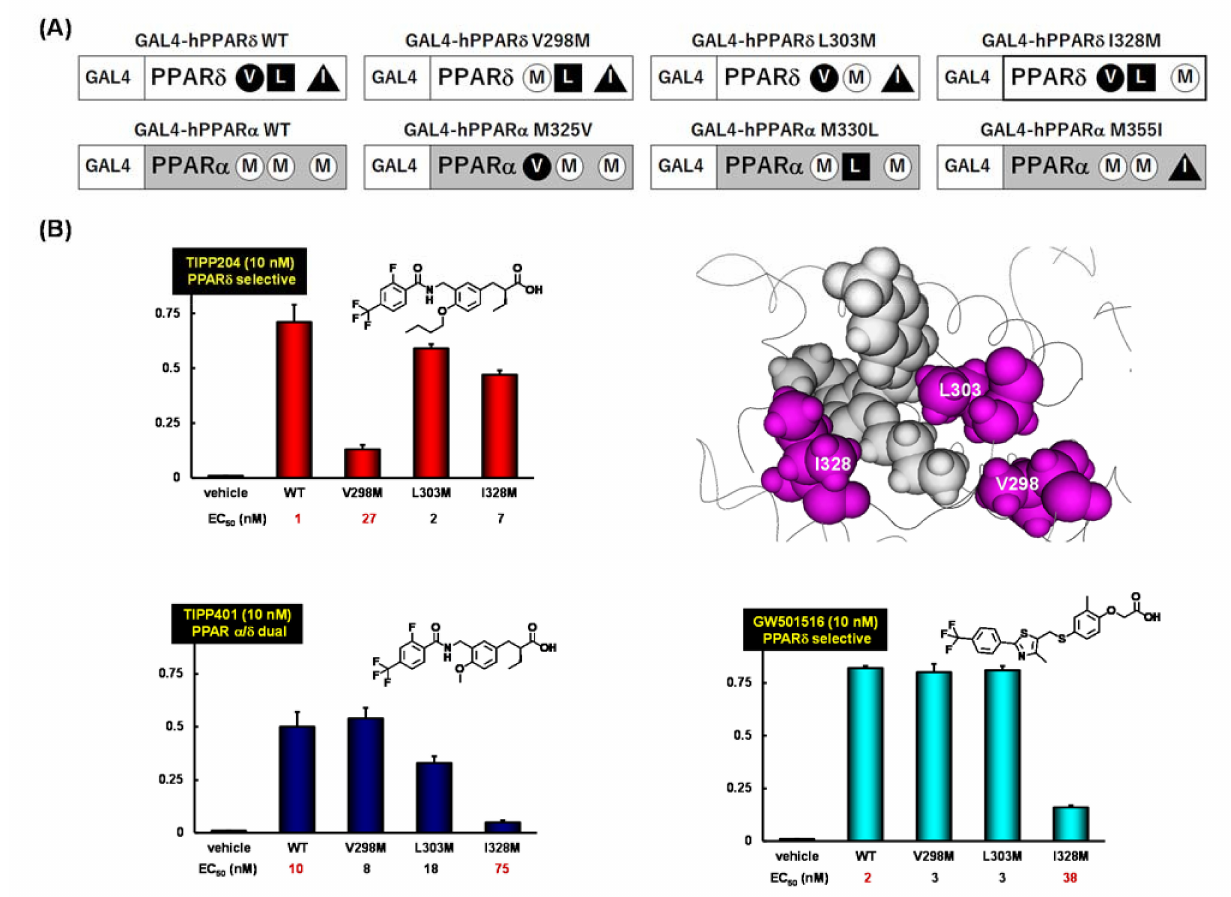
Figure 10. ( A ) A schematic representation of GAL4-fusion point mutants; ( B ) Dose responses for transactivation of the GAL4-fusion point mutant constructs with TIPP-204, TIPP-401 and